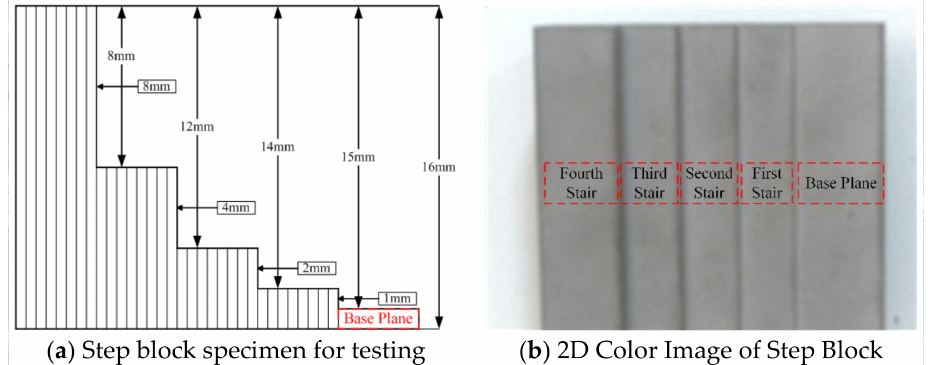
Figure 16. Precision measurement of the codec is performed through capturing the step block: ( a ) the specimen of the step block; and ( b ) the 2D color image of the captured step